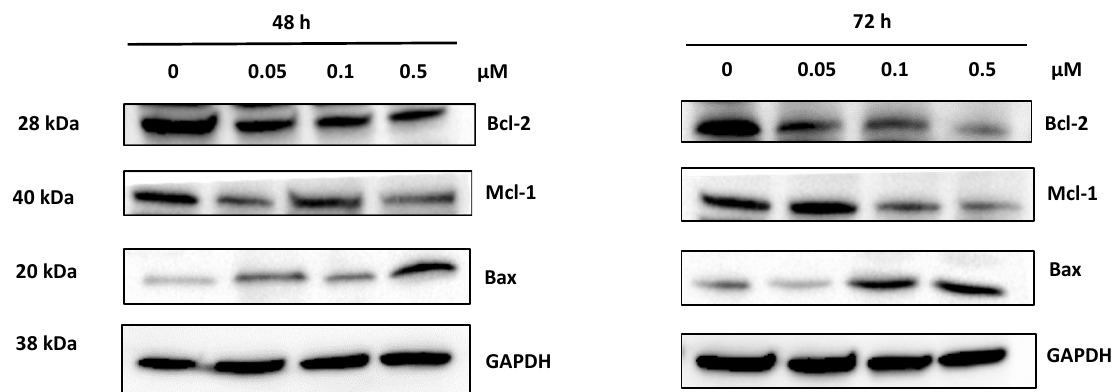
Figure 10. Effects of compound 10n on expression of pro-apoptotic protein Bax and anti-apoptotic proteins Bcl-2 and Mcl-1 in MCF-7 cells. MCF-7 cells were treated with either vehicle control (ethanol, 0.1% v / v ) or with compound 10n (0.05, 0.1 and 0.51 µ M) for 48 or 72 h. After the required time, the cells were then harvested and separated using SDS PAGE to detect the level of the pro-apoptotic protein Bax and anti-apoptotic proteins Bcl-2 and Mcl-1. Results are representative of two separate experiments performed independently. To confirm equal protein loading, each membrane was stripped and re-probed with a GAPDH antibody.